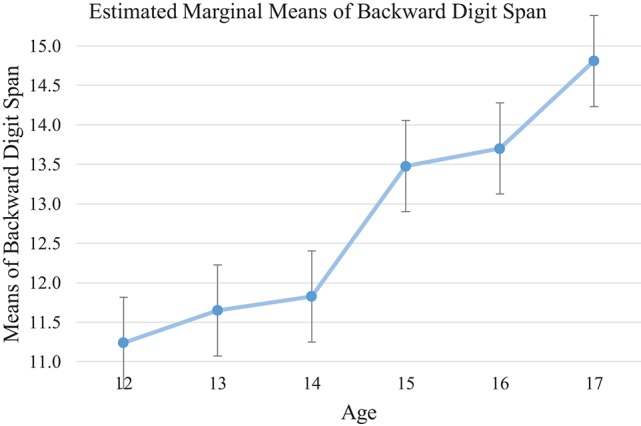
Mean of each age group on backward digit span test. Processing Speed improves across different ages with a spurt between age of 14 and 15.